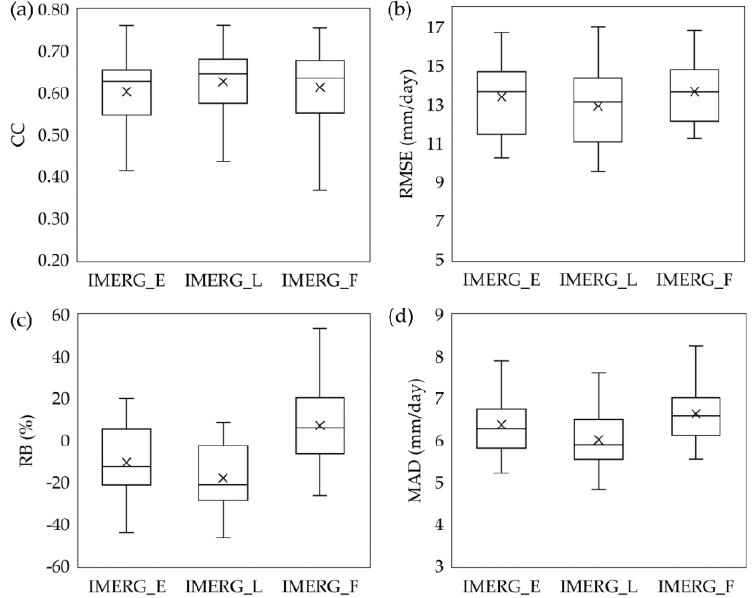
Figure 3. Box plots of ( a ) Correlation Coefficient (CC); ( b ) Root Mean Square Error (RMSE) ( c ) Relative Bias (RB) and ( d ) Mean Absolute Difference (MAD) of the GPM IMERG products against gauge for daily precipitation assessment from 12 March 2014 to 31 December 2016. Table 1. Statistical analysis of the IMERG products.